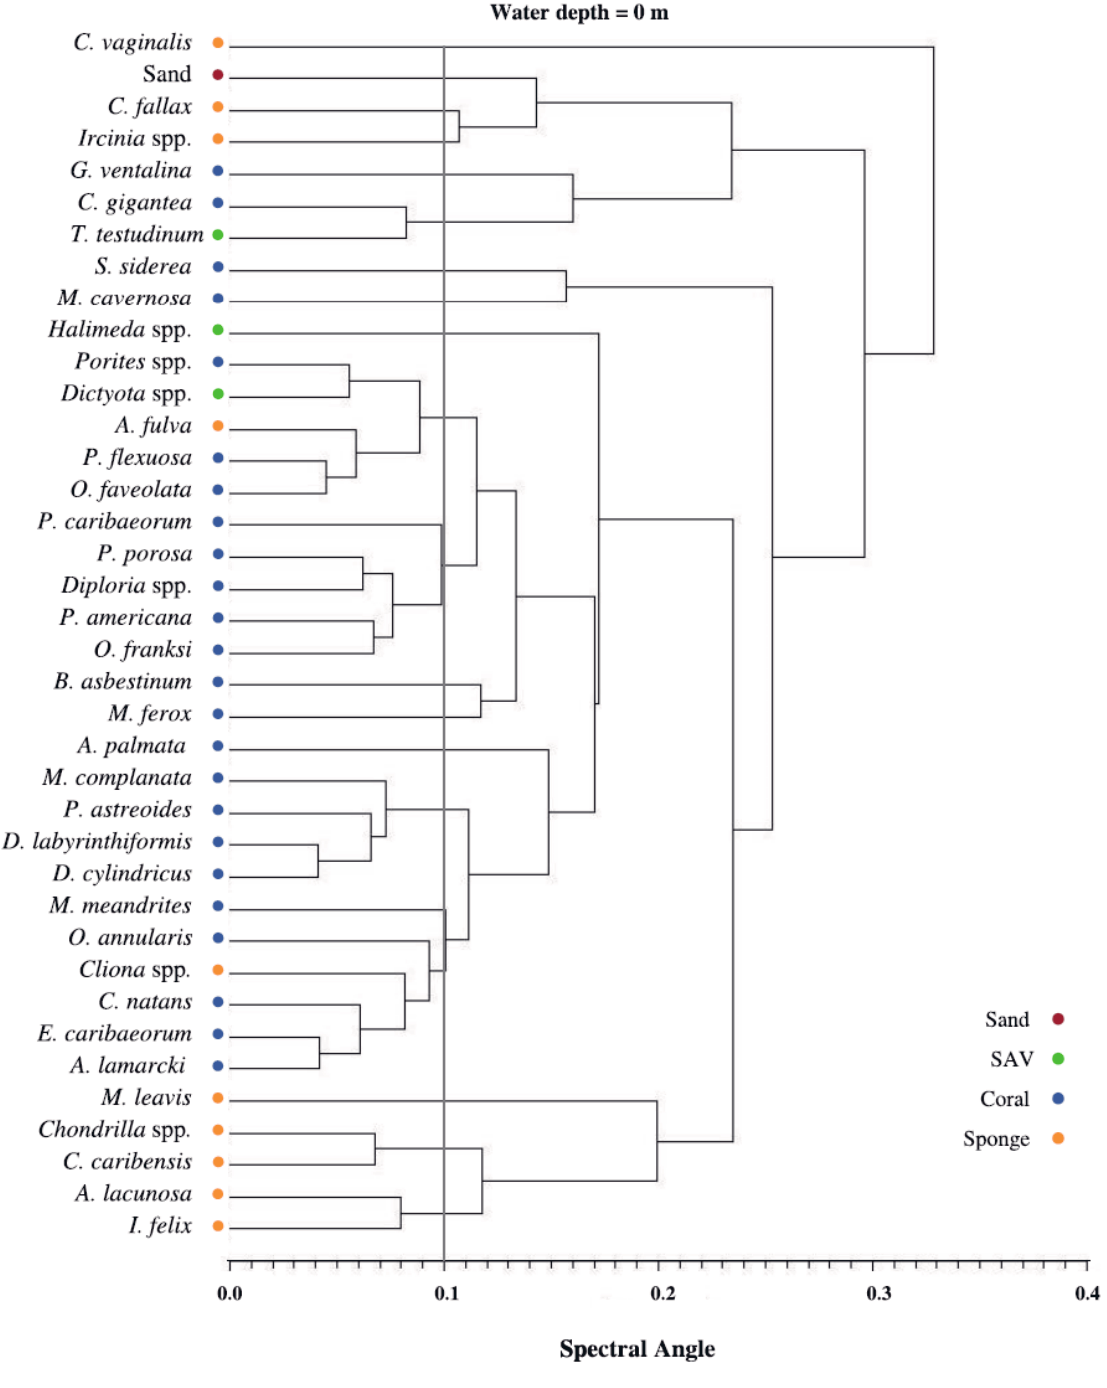
Figure 6. Optical dendrogram for 0 m water depth illustrating separability of field spectra from 24 coral species, 10 sponge species, 3 submerged aquatic vegetation (SAV) species, and